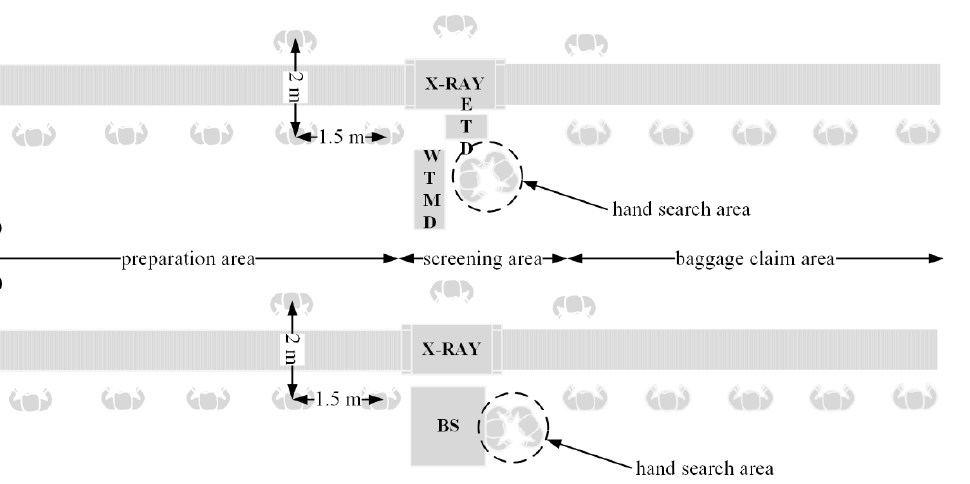
Figure 2. Simplified diagrams of security lanes: ( a ) procedure for the WTMD screening method, ( b ) procedure for the BS screening method.